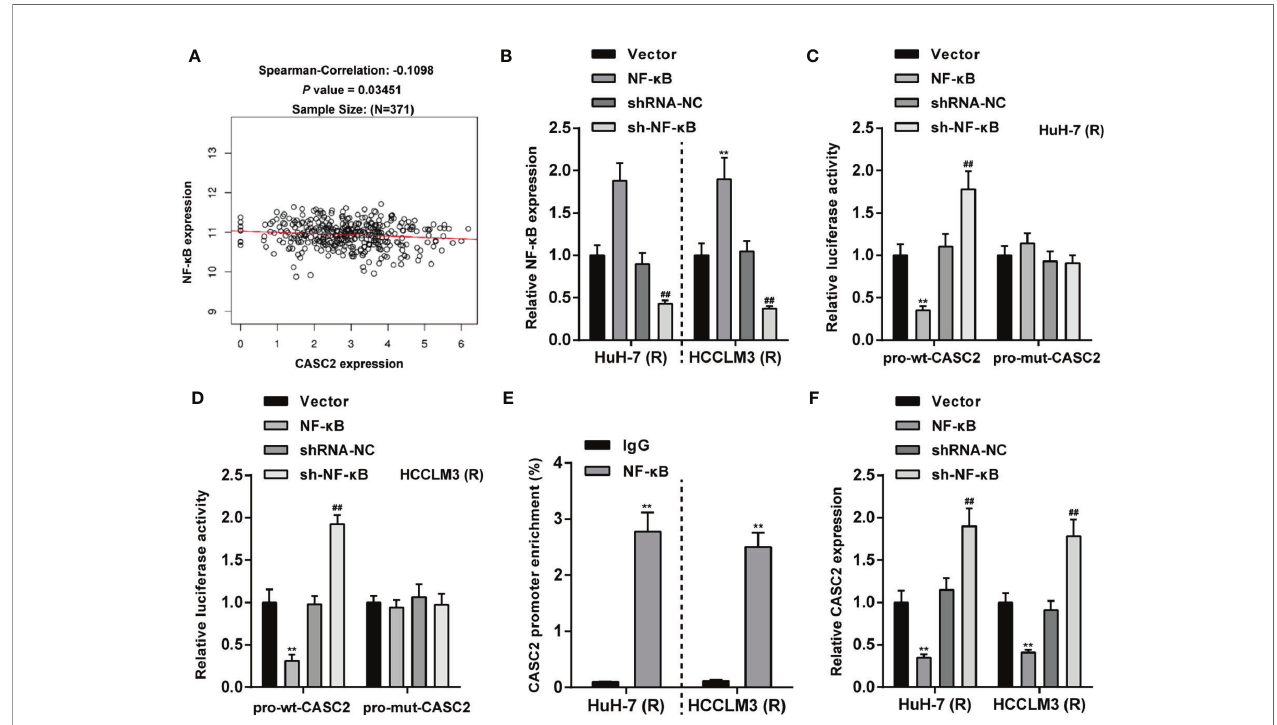
FIGURE 8 | The transcription factor NF- k B inhibits lncRNA CASC2 transcription. (A) TCGA hepatocellular carcinoma data (TCGA_LIHC) were analyzed using Spearman ’ s correlation analysis for the correlation between lncRNA CASC2 and RELA. (B) NF- k B overexpression or knockdown was achieved in Huh-7 (R) and HCCLM3 (R) cells by transfecting NF- k B-overexpressing plasmid (NF- k B) or short hairpin RNA targeting NF- k B (sh-NF- k B); the transfection ef fi ciency was con fi rmed using qRT-PCR. (C, D) Wild- and mutant-type CASC2 promoter luciferase reporter plasmids were co-transfected with NF- k B or sh-NF- k B, and the luciferase activity was determined. (E) ChIP assay was performed using anti-IgG or anti-NF- k B, and the levels of CASC2 promoter in immunoprecipitate by anti- IgG or anti-NF- k B were determined using qRT-PCR. (F) Huh-7 (R) and HCCLM3 (R) cells were transfected with NF- k B or sh-NF- k B and examined for CASC2 expression using qRT-PCR. **p < 0.01, compared with vector or IgG group, ## p < 0.01, compared with shRNA-NC